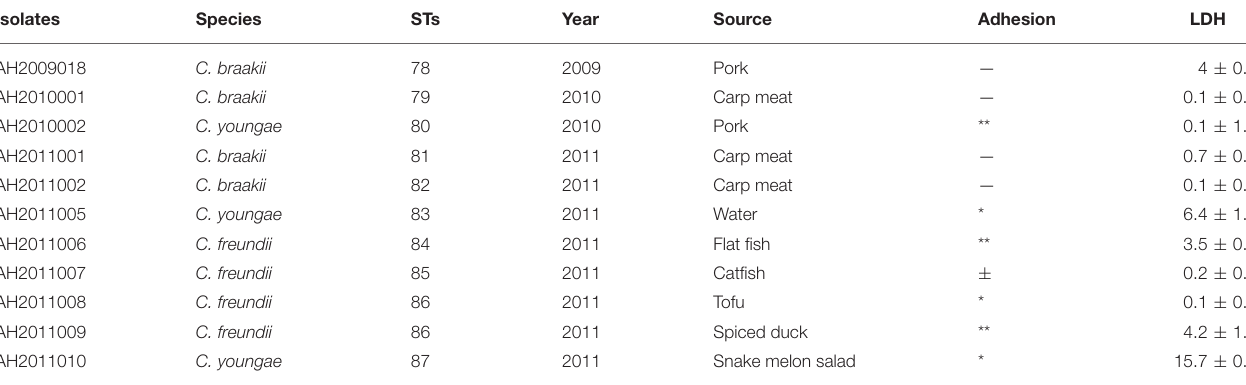
and eight C. Braakii isolates were divided into 53 STs by MLST ( Table 1 ). The 41 C . younga e isolates were divided into 32 STs, 13 C. freundii isolates into 12 STs and eight C. Braakii isolates into 8 STs. Four STs (ST25, ST28, ST39, and ST59), all belonging to C. youngae , contained multiple isolates from two to five isolates. ST25 and ST28 each contained two isolates from diarrheal patients. ST39 contained five isolates with one from a diarrheal patient and four from foods. All three ST59 isolates were from